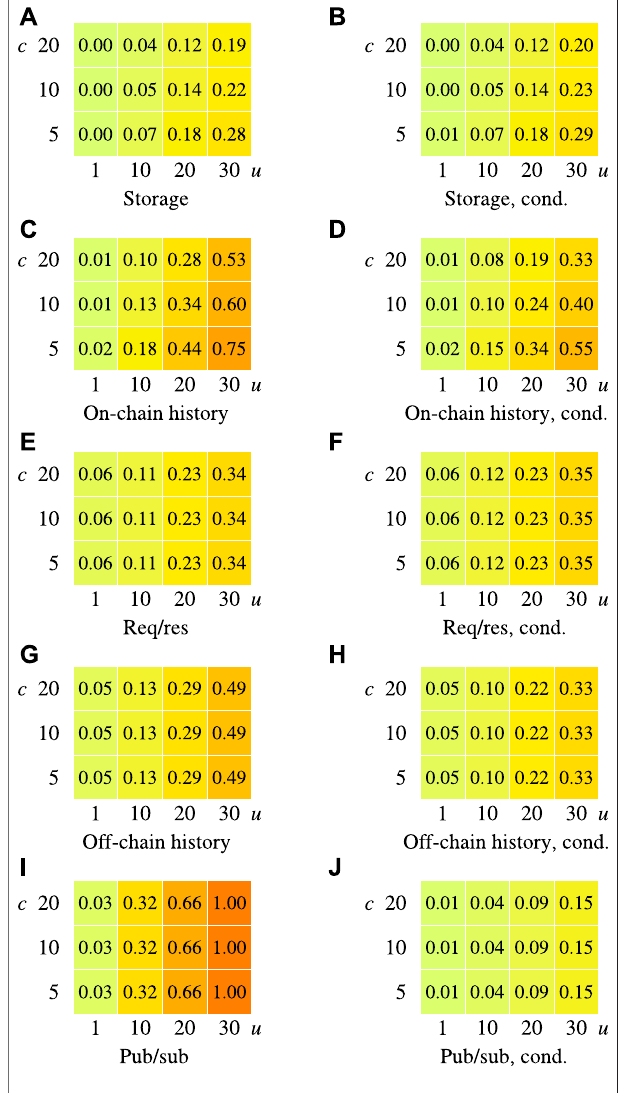
FIGURE 8 | Normalized, relative operating cost of an oracle per consumer with the given number of data updates u and consumers c .